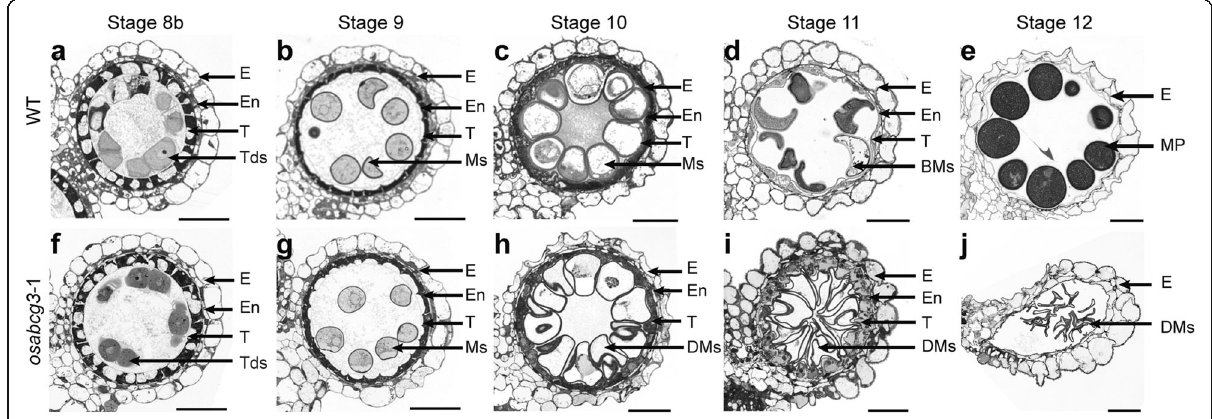
Fig. 4 Transverse sections of anther in WT and osabcg3 – 1 from stage 8b to 12. WT anthers are showed in a-e . osabcg3 – 1 anthers are showed in f-j . BMs, binuclear microspores; DMs, degenerated microspores; E, epidermis; En, endothecium; MP, mature pollen; Ms., microspores; T, tapetal layer; Tds, tetrads. Scale bars = 20 μ